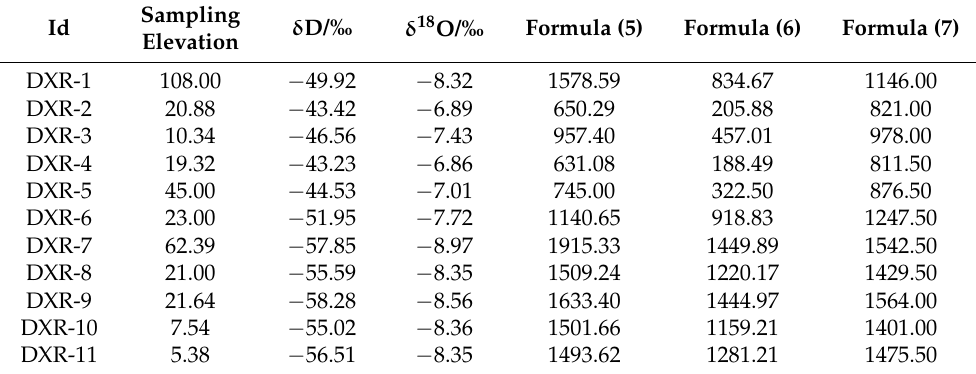
Table 4. Geothermal water recharge zone elevation